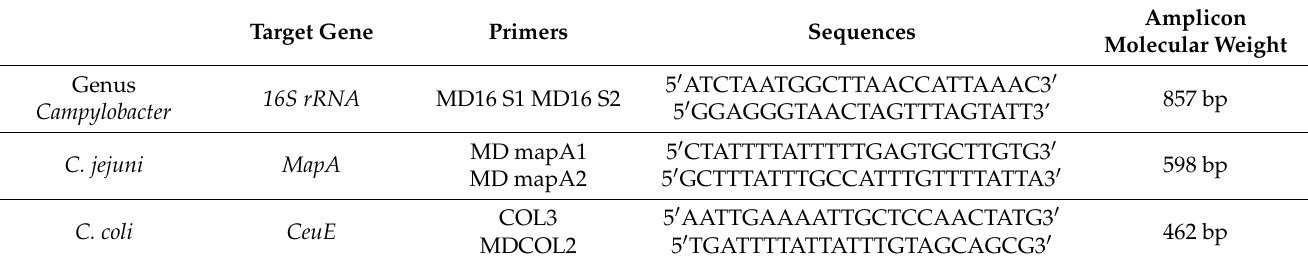
Table 2. Primers and sequences used for the identification of C. jejuni and C. coli